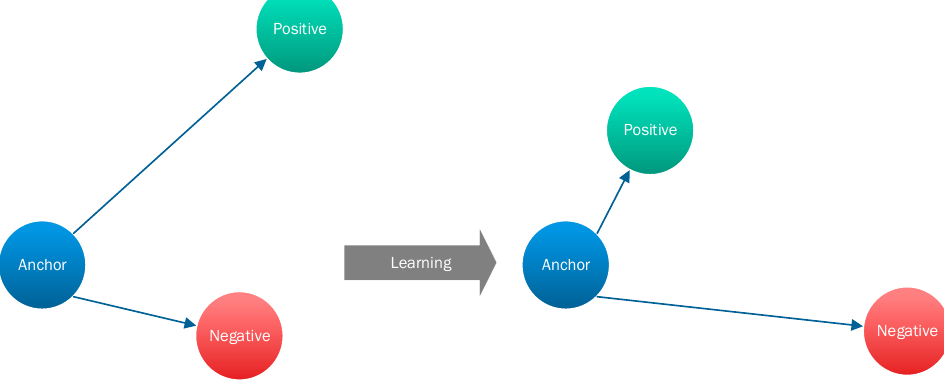
Figure 7. An example of the training process of a Siamese Neural Network (SNN) using triplet loss.